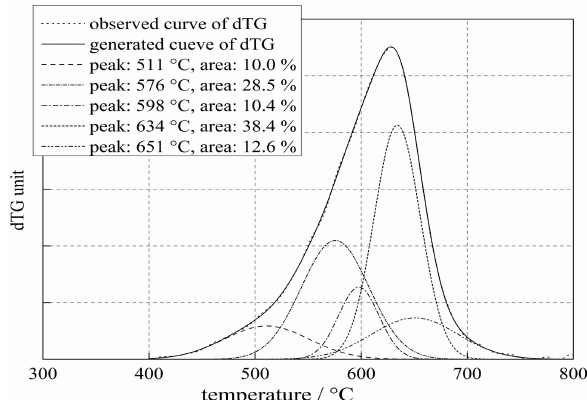
Figure 7. Examples of derivative thermogravimetry (DTG) curves of cv / tv smectites. Sample XL_13_14TR03 with 51.1% cv layers and 48.9% tv